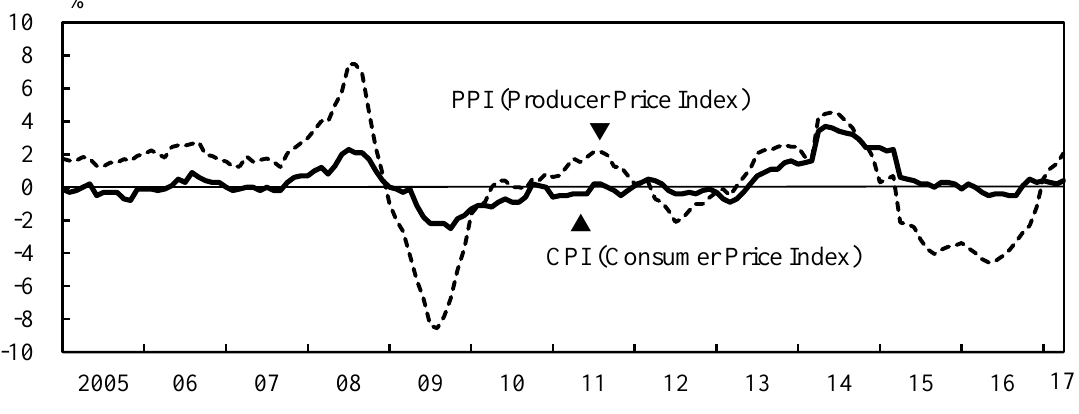
(1) Consumer Price Index (CPI) The all items index of consumer prices (with base year 2015 = 100) was 99.9 in 2016, down 0.1 percent from the previous year.